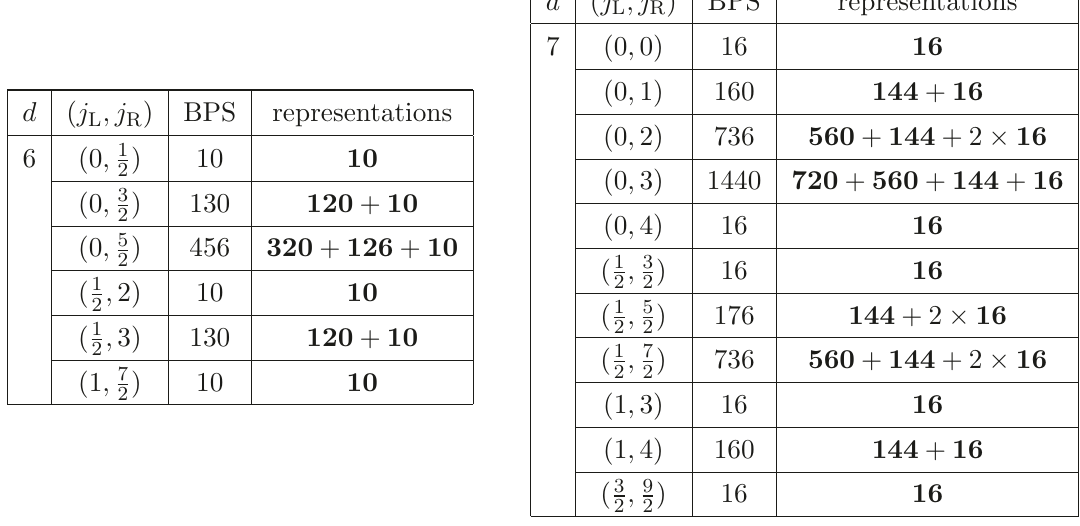
Table 2 . The constituent representations for the total BPS indices of the (2 , 2) model for d = 6 ,